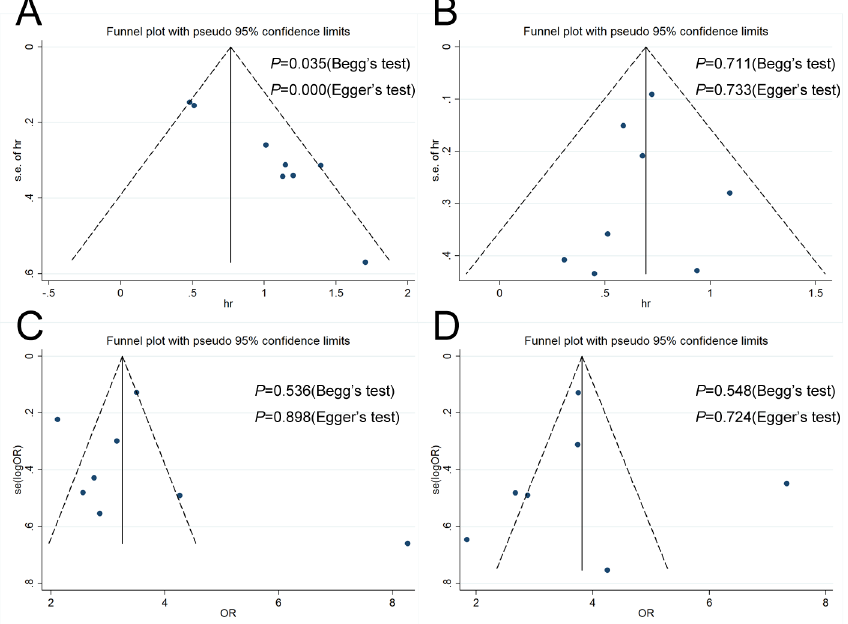
Fig 3. Funnel plots, Begg and Egger tests result for the evaluation of potential publication bias. Plots are arranged as follows: (A) RCC CSS; (B) MRCC OS; (C) PC pT stage; (D) PC Fuhrman